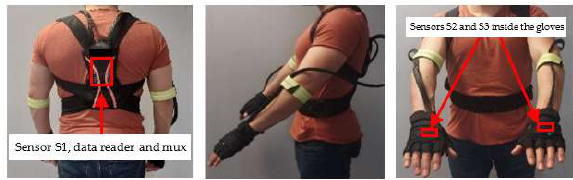
Figure 3. Sensor system and attachment instruments.